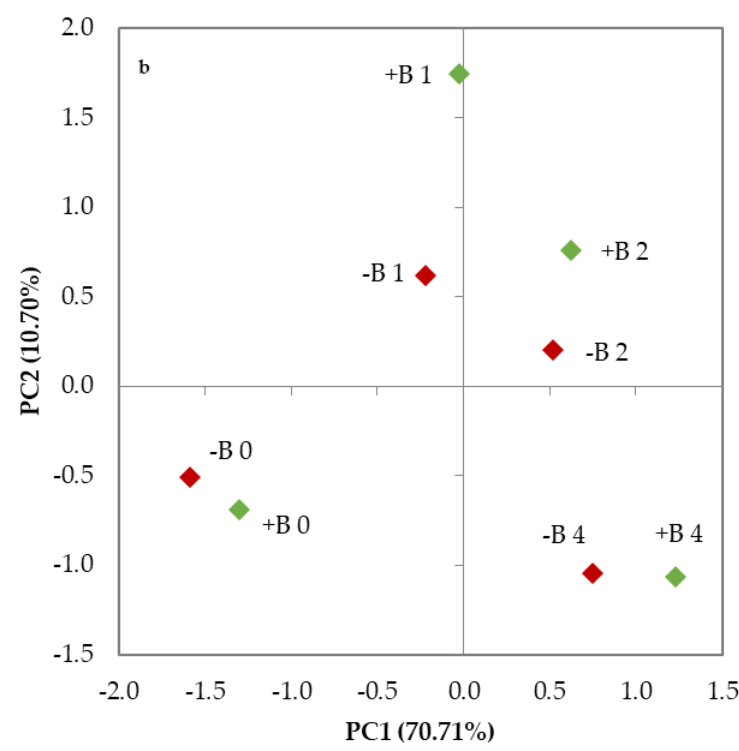
Figure 3. Plot of ( a ) loadings (morphophysiological and quality characteristics of lettuce seedlings and plants) and ( b ) scores (trials) formed by the two principal components from the PCA analysis. –B 0, -B 1, -B 2, and -B 4: uninoculated lettuce fertigated during nursery growth with 0, 1, 2, and 4 g L − 1 of fertilizer, respectively; +B 0, +B 1, +B 2, and +B 4: inoculated lettuce fertigated during nursery growth with 0, 1, 2, and 4 g L −1 of fertilizer, respectively.